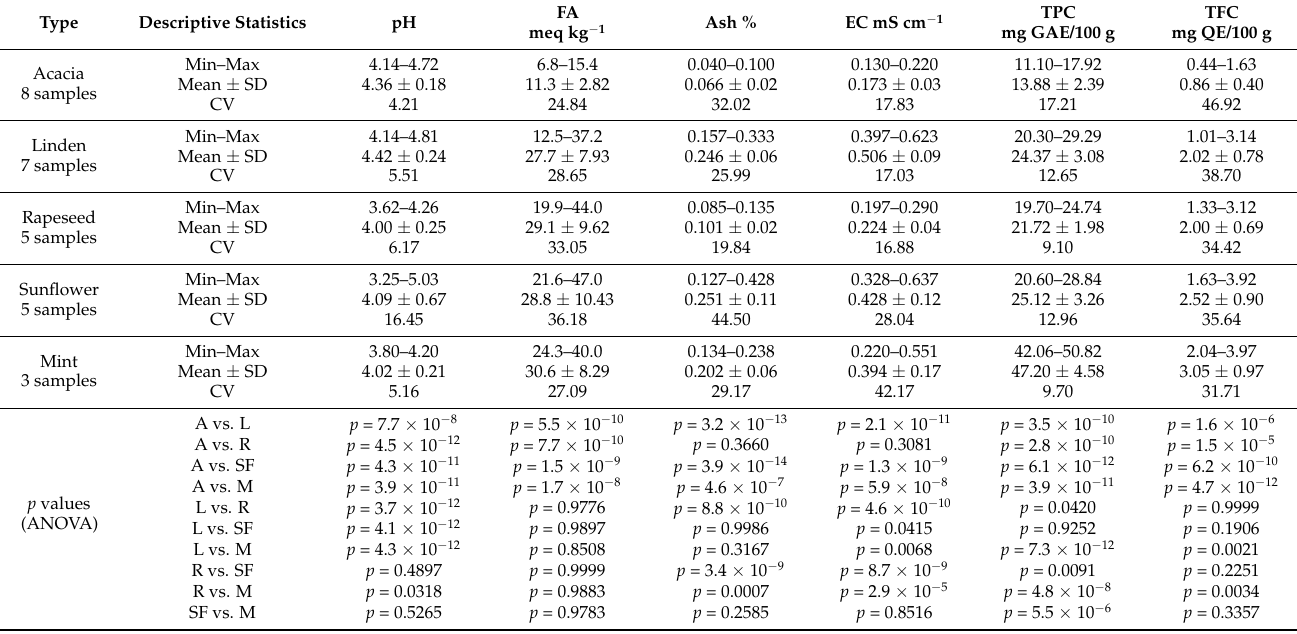
Table 2. Parameter (pH, free acidity, ash, electrical conductivity, total phenolic content, total flavonoid content) values of honey